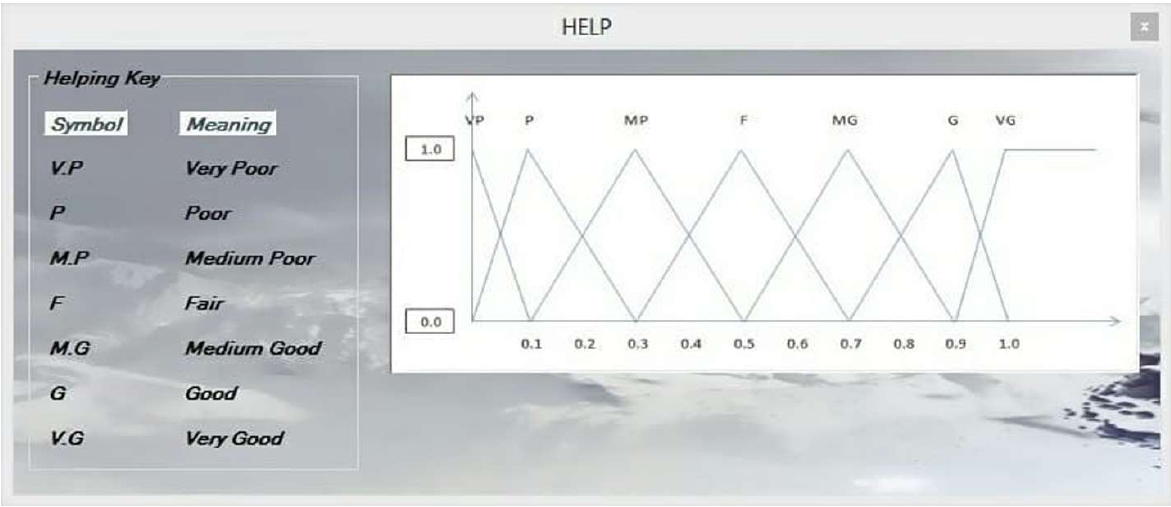
Figure 4. TFNs Membership